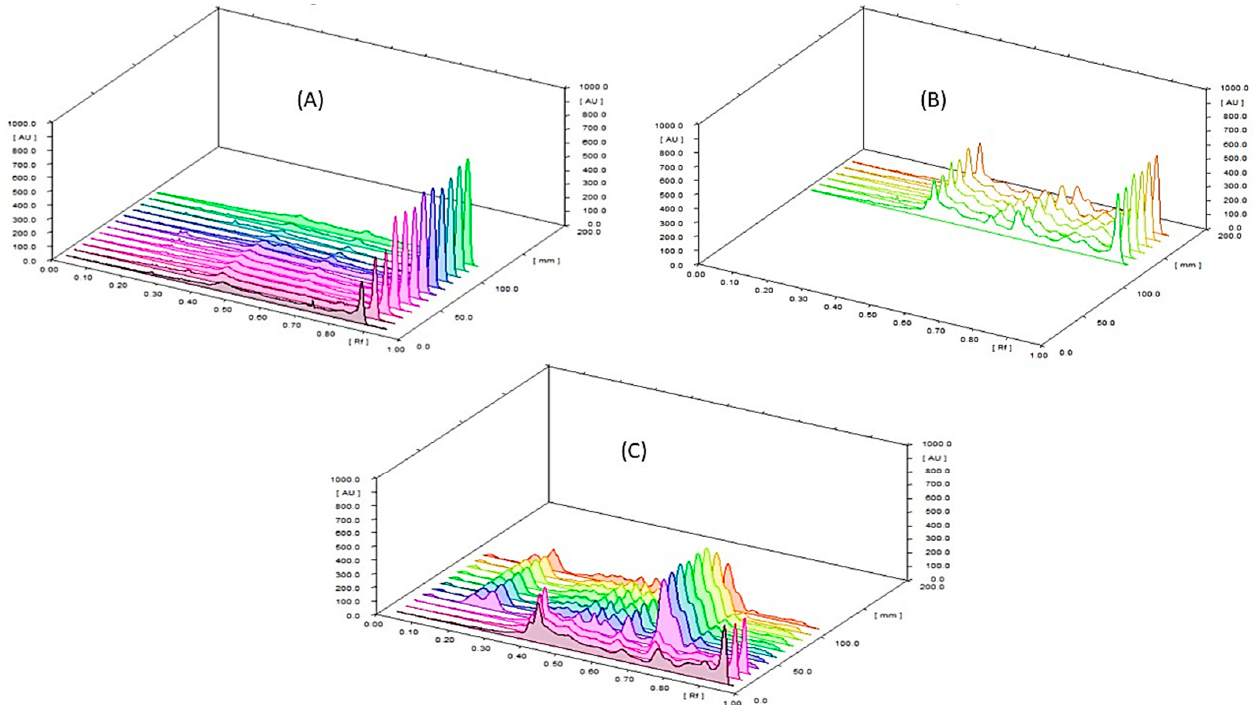
Figure 8. HPTLC chromatogram of β -carotene in ( A ): reference standard; ( B ): SP and ( C ): NCF (the first three pink tracks represent the β -carotene for SP while the rest of the tracks represent